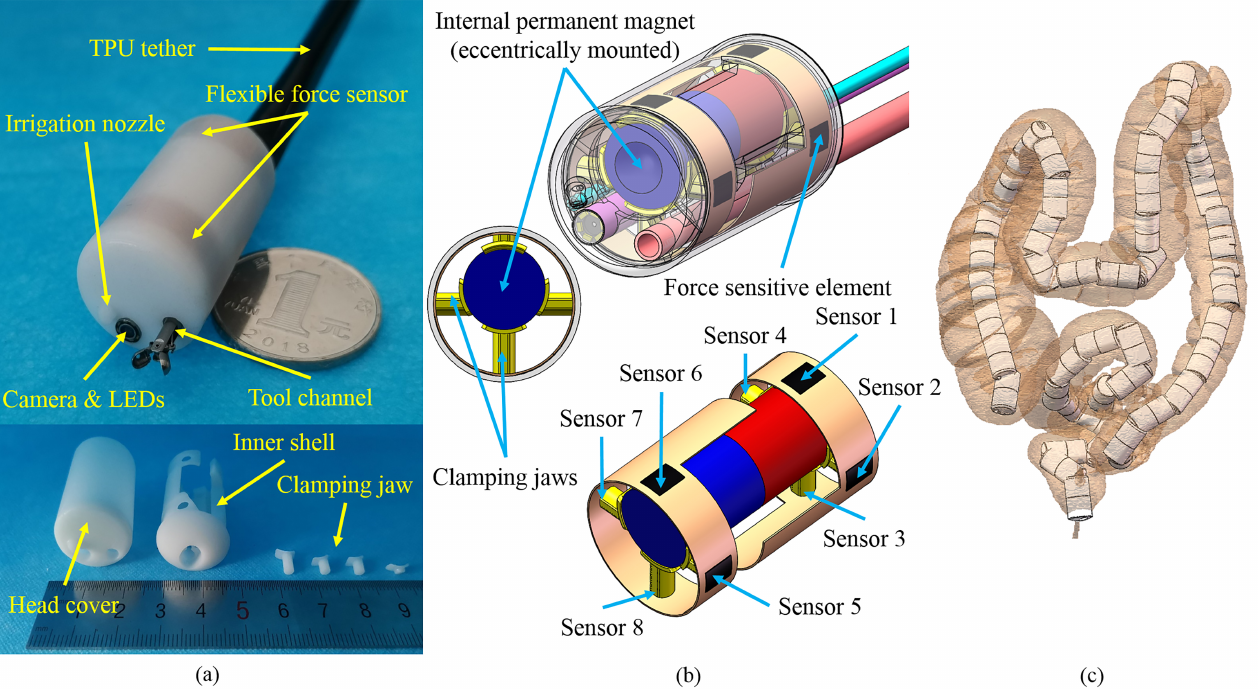
Figure 2. Designed magnetic capsule endoscope with flexible force sensors. ( a ) Mechanical structure. ( b ) Distribution of force sensitive elements. ( c ) Simulation of the motion of the designed magnetic capsule inside a reconstructed human large